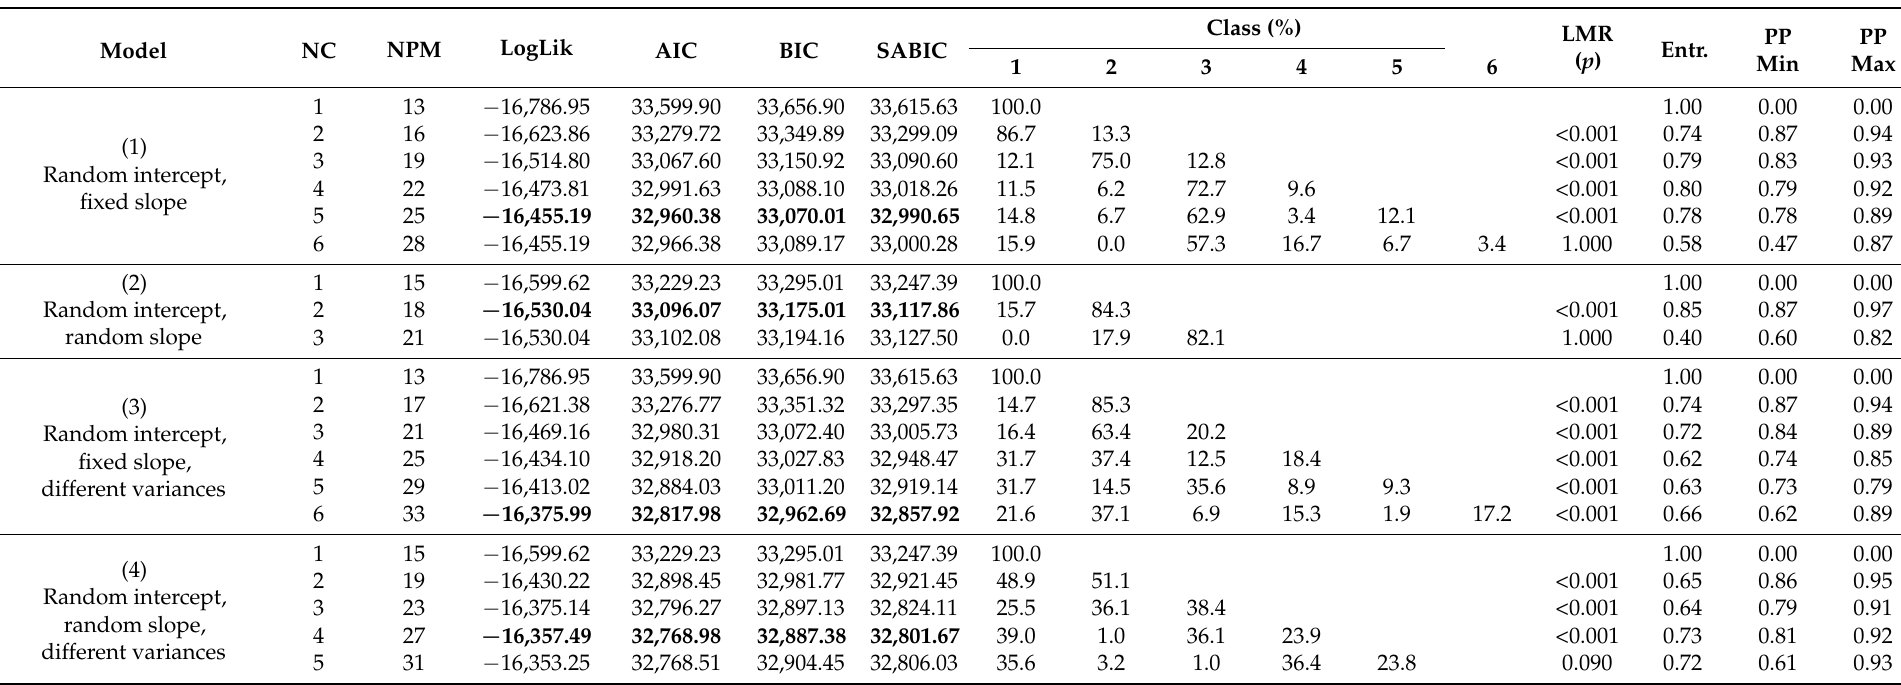
Table A10. Multivariate Latent Class Growth Analysis for PHQ-9, GAD-7, PCL-5 and RPQ for participants with moderate or severe TBI (N =